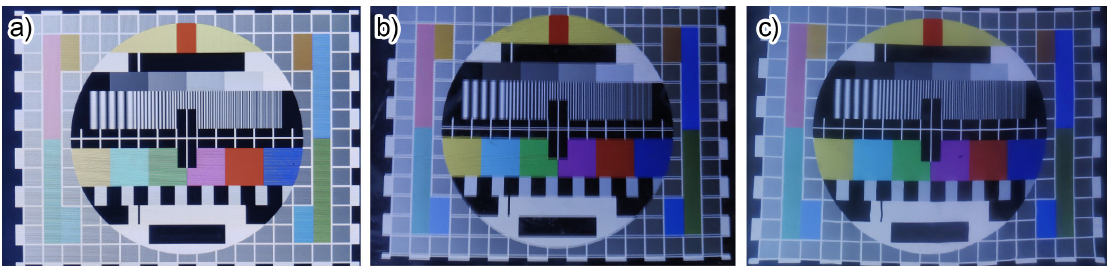
Figure 5. Calibration template ( a ) captured under the same conditions ( b ) from the monitor and ( c ) reflected on a 2-mm sheet and reflected on a 0.25-mm sheet.